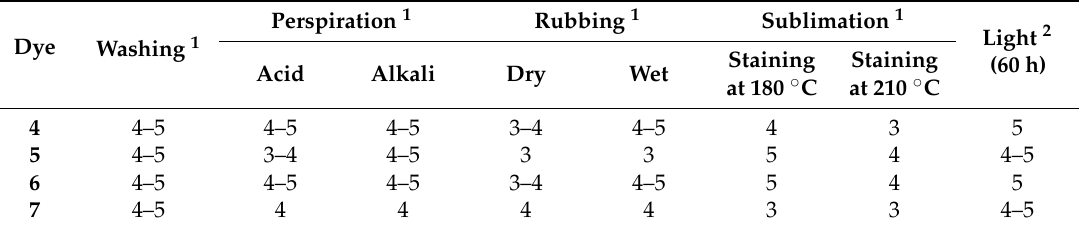
Table 1. Fastness properties of the synthetic dyes on polyester fabrics.